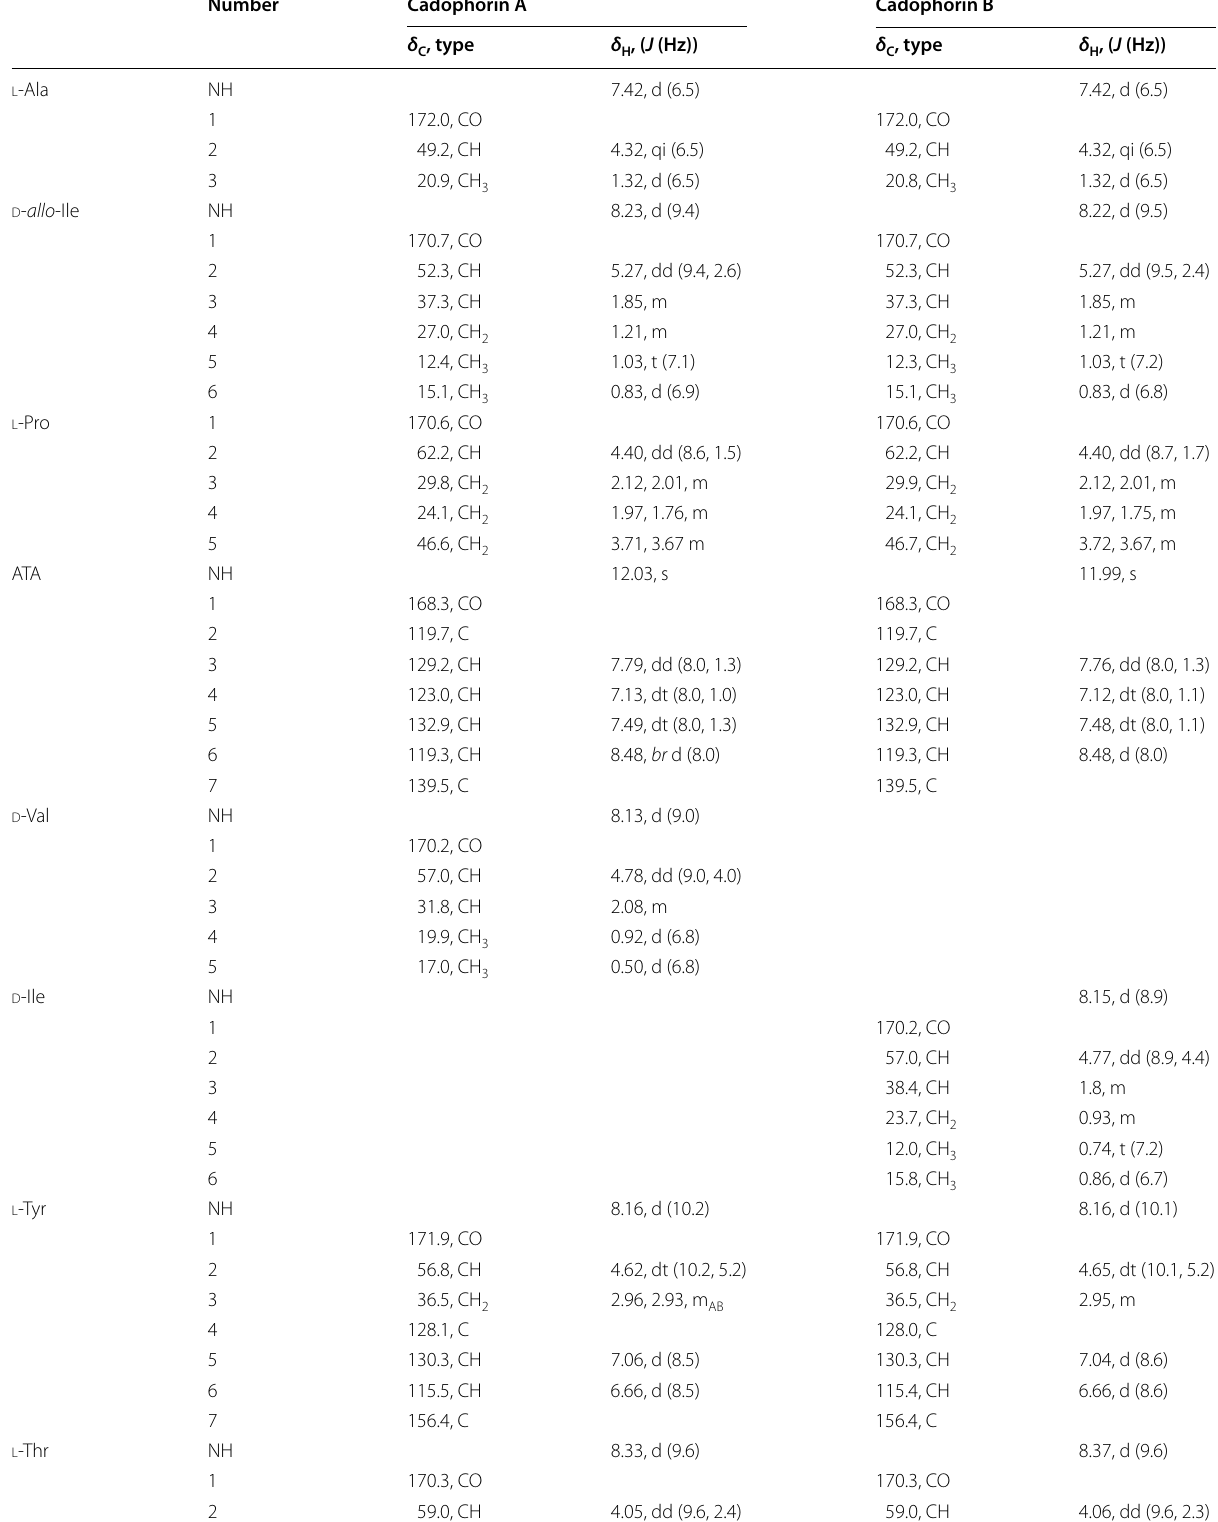
Table 1 13 C NMR (500 MHz) and 1 H NMR (125 MHz) data for cadophorins A and